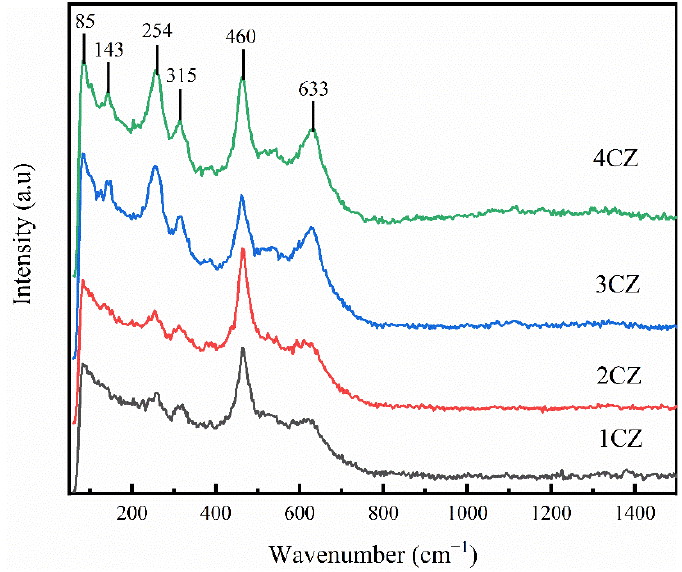
Figure 5. Raman spectra for the CZ nanoparticles.